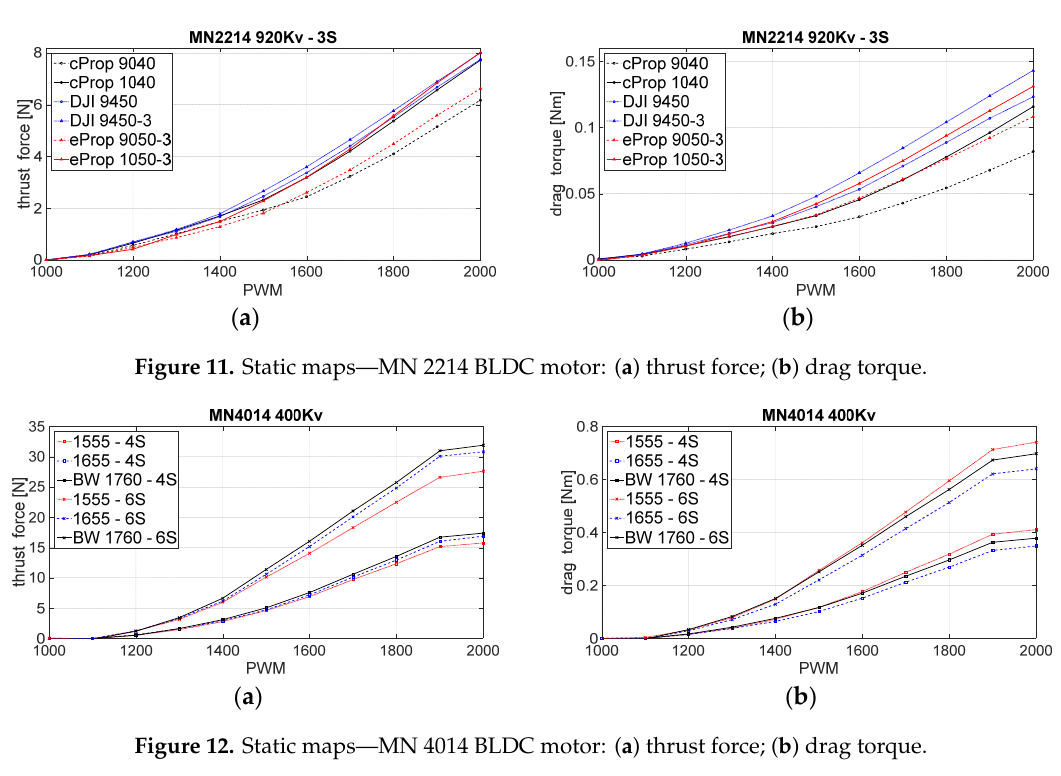
Figure 10. Static maps—1806 BLDC series: ( a ) thrust force; ( b ) drag torque.